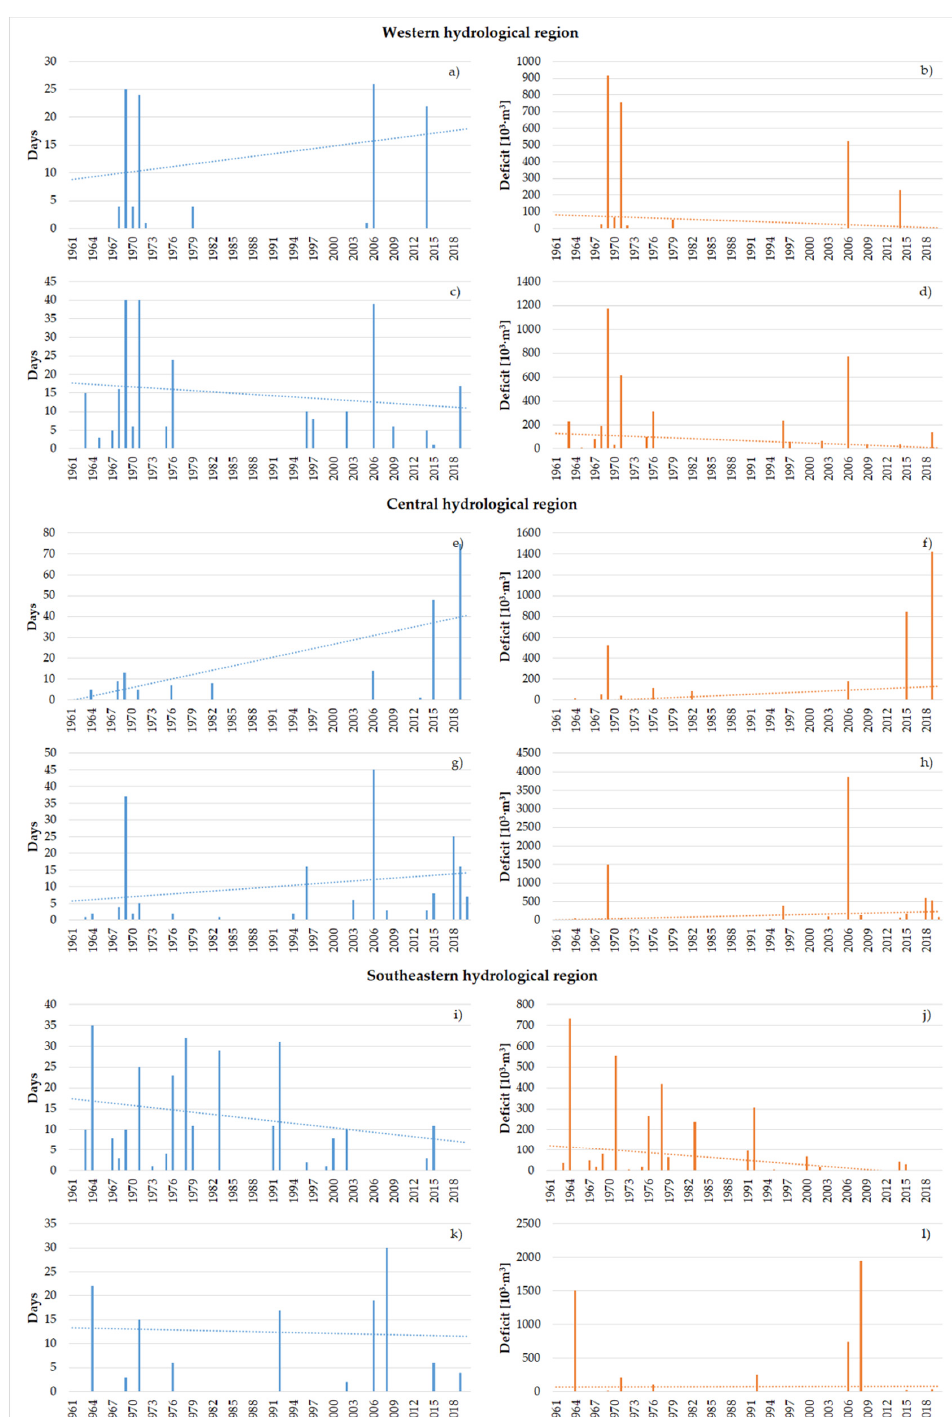
Figure 11. Examples of drought changes for 30Q95 threshold over time: ( a ) days with drought in JUR river, ( b ) deficit volume in JUR river, ( c ) days with drought in MIN river, ( d ) deficit volume in MIN river, ( e ) days with drought in SES river, ( f ) deficit volume in SES river, ( g ) days with drought in VEN2 river, ( h ) deficit volume in VEN2 river, ( i ) days with drought in VER river, ( j ) deficit volume in VER river, ( k ) days with drought in ZEI river, ( l ) deficit volume in ZEI river.